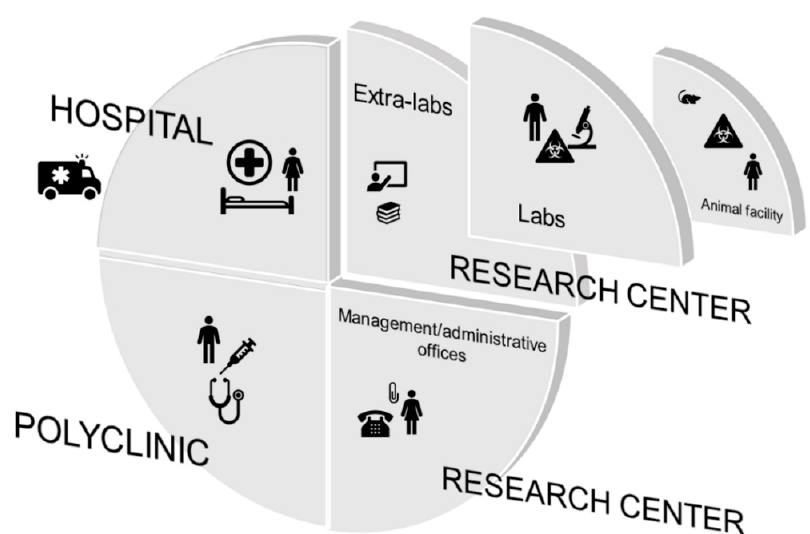
Figure 1. Sub-contexts from which to start for risk assessment: general, extra-lab, and research lab. The general sub-context is represented by the hospital, the polyclinic, and the management and administrative offices. What is defined as a “research laboratory” is made up of two different environments: extra-lab areas where bibliographic research, writing of scientific works, or projects meetings and teaching activities take place; and lab areas where experiments are carried out. Table 2. Levels of risks assessment to consider for sub-context, operator, and